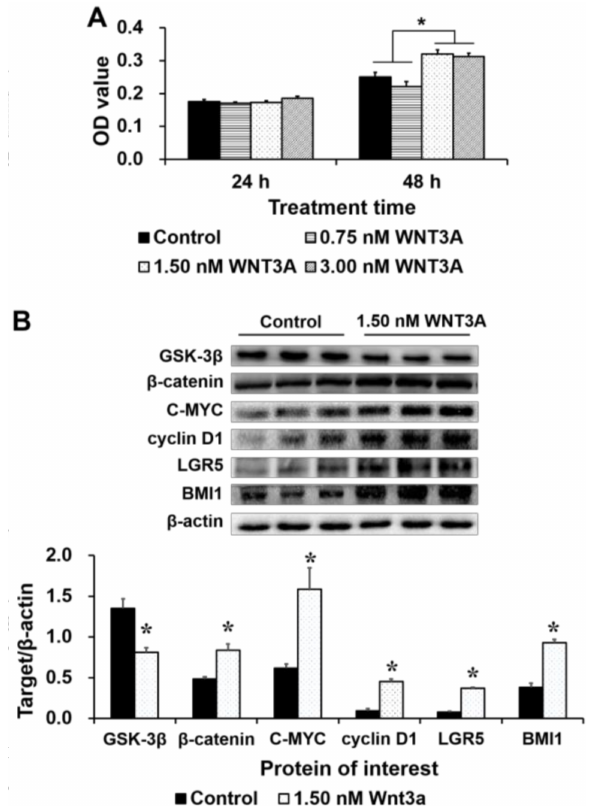
Figure 6. The effects of rhWNT3A protein supplementation on cell proliferation and protein expression in IPEC-J2 cells. ( A ) The OD values were higher in the 1.5- and 3.0-nmol/L WNT3A groups than in the control group at 48 h after treatment, as assessed by the MTT assay ( n = 20); and ( B ) The levels of WNT/ β -catenin signaling-related proteins, LGR5 and BMI1 were assessed by Western blot ( n = 3). The results were confirmed by three independent experiments per treatment. Representative results of the three independent experiments are shown. The bars are the means ± SE, * indicates a significant difference ( p <